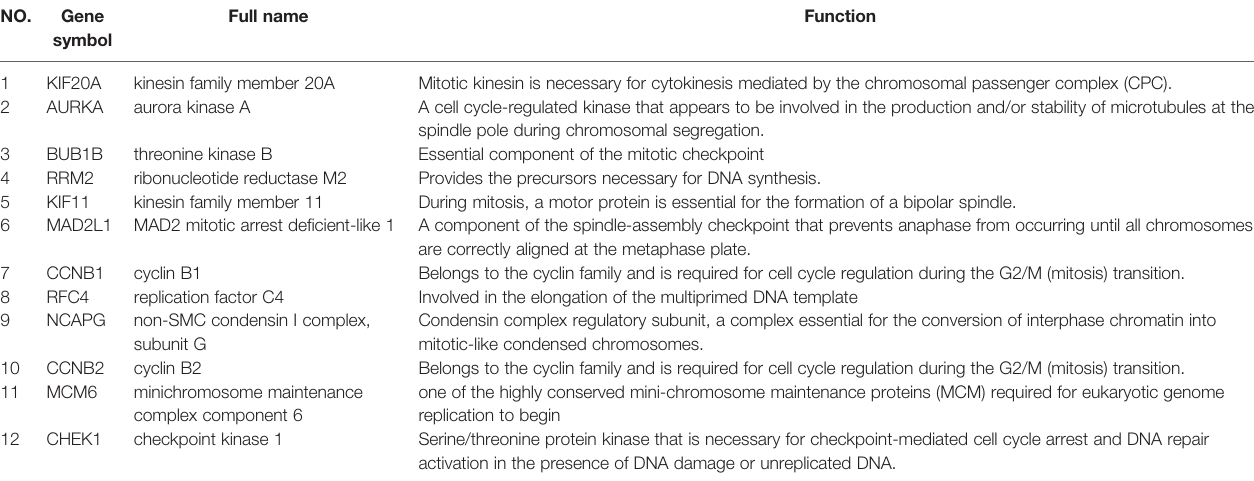
TABLE 1 | Functional roles of 12 hub